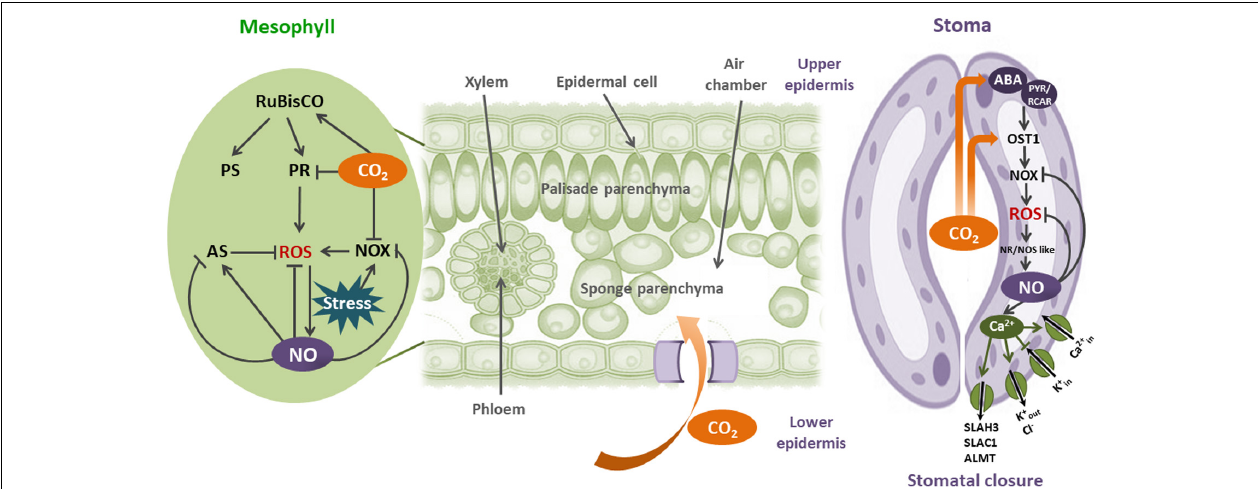
FIGURE 2 | Interplay between CO 2 and NO in plant redox physiology: CO 2 enters to the leaves by stomata. Once in mesophyll cells, CO 2 increase photosynthesis (PS) through the CO 2 -unsaturated Rubisco activity. When plants are in stress environments, ROS could be augmented by Rubisco-induced photorespiration